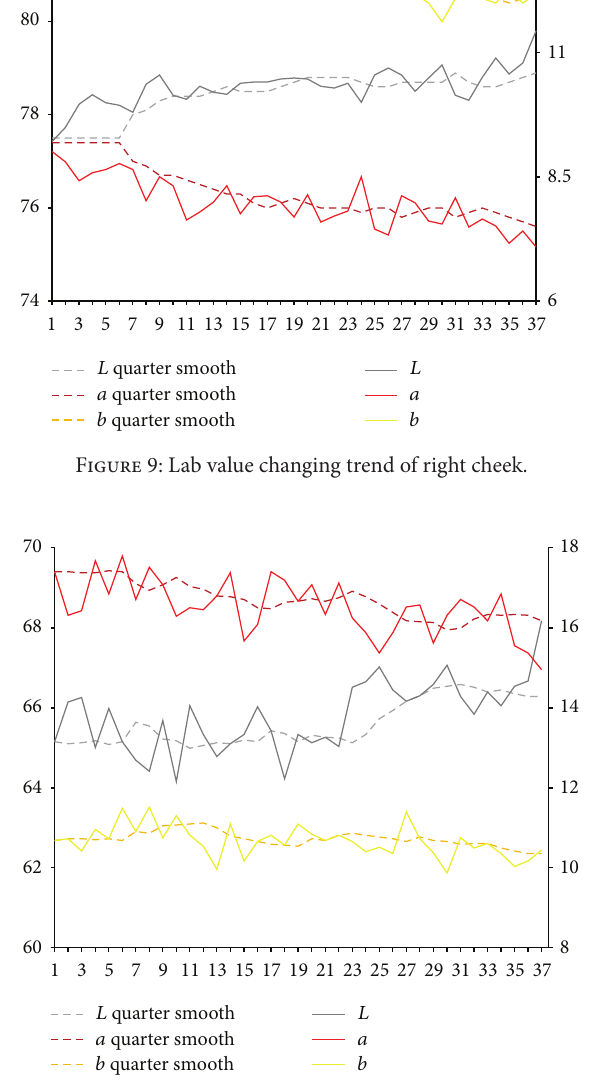
Figure 10: Lab value changing trend of lip.